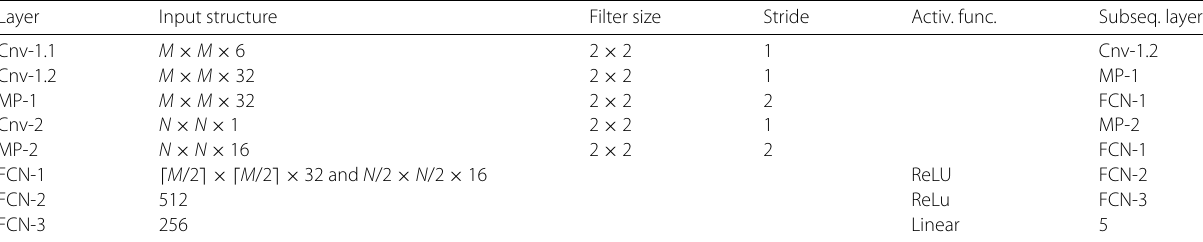
Table 1 Structure of network Layer Input structure Filter size Stride Activ. func. Subseq. layer